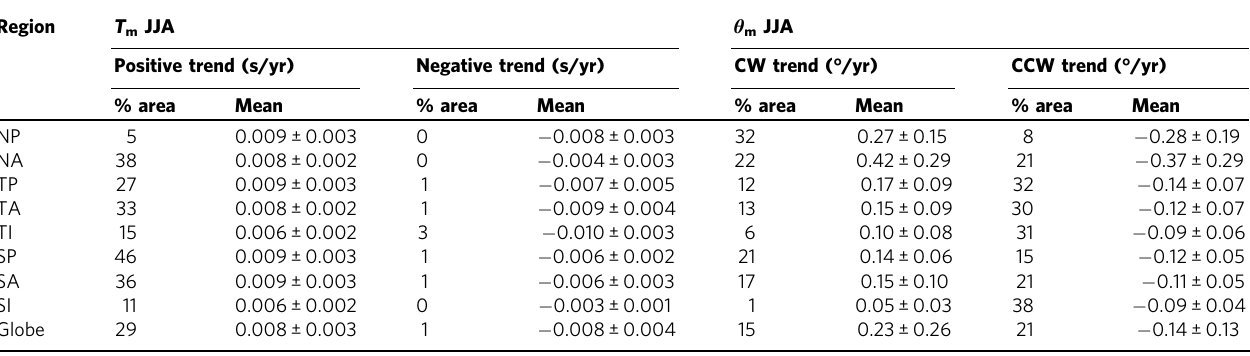
Table 5 Ensemble mean trends and percent area experiencing robust signals of change for T m (seconds per year) and θ m (degrees per year) for the JJA season.